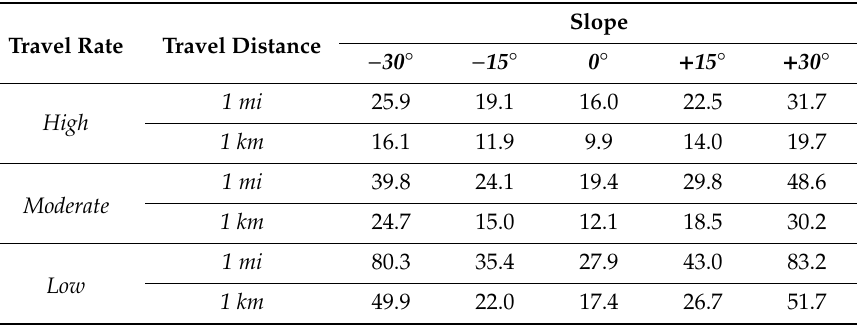
Table 4. Travel time estimates, in minutes, for the three wildland firefighter travel rate functions (low, moderate, and high), based on two di ff erent fixed travel distances (1 mile and 1 km), across five di ff